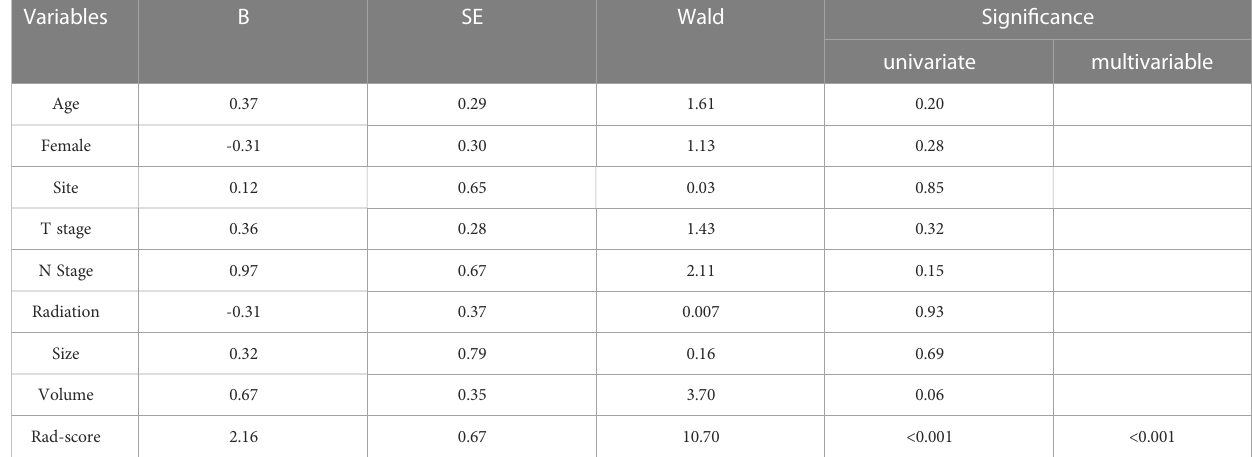
TABLE 2 Logistics regression analyses for PR status in the training